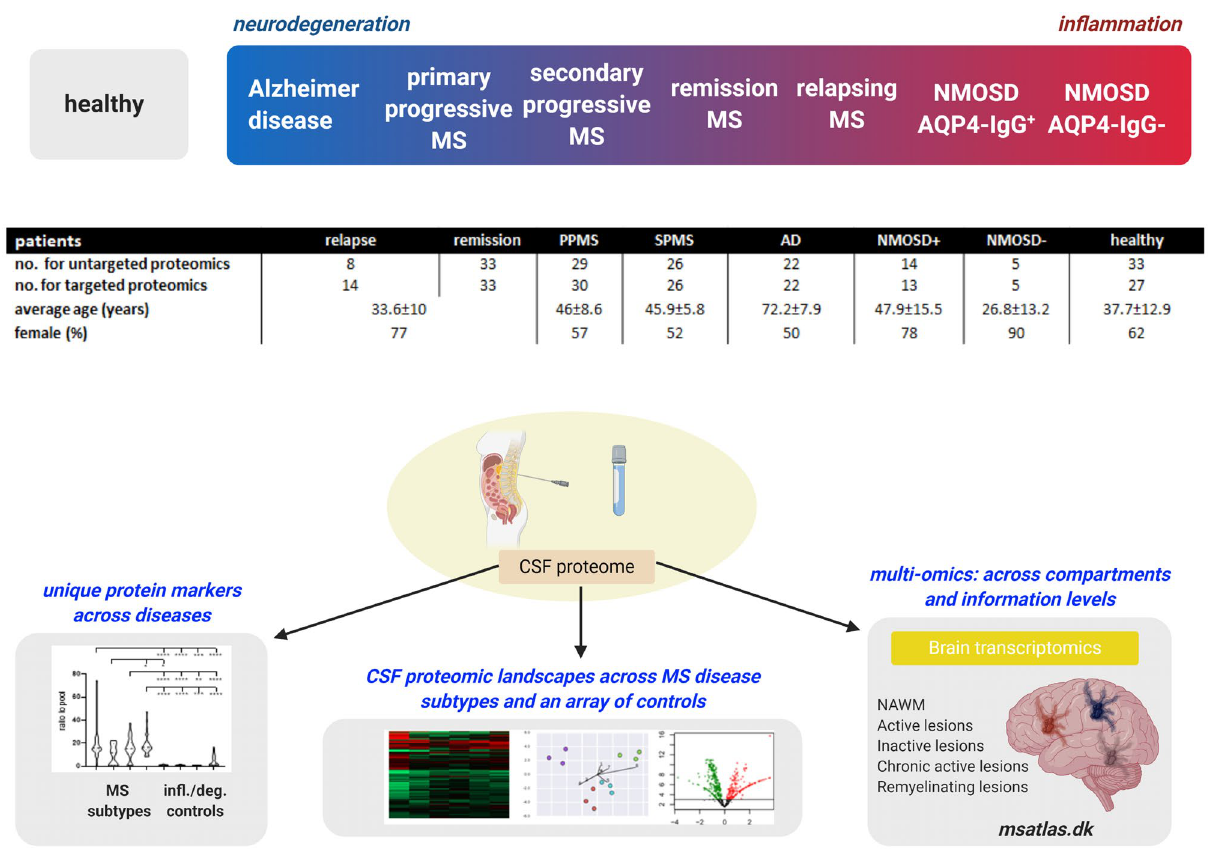
Figure 1. A multi-omics approach to identify molecules that characterize MS subtypes. An outline of the study is shown with an overview of CSF and brain samples collected for the comprehensive proteomic study and its overlap with brain lesion transcriptomes. MS multiple sclerosis, NAWM normal-appearing white matter, NMOSD neuromyelitis spectrum disorder. Created with